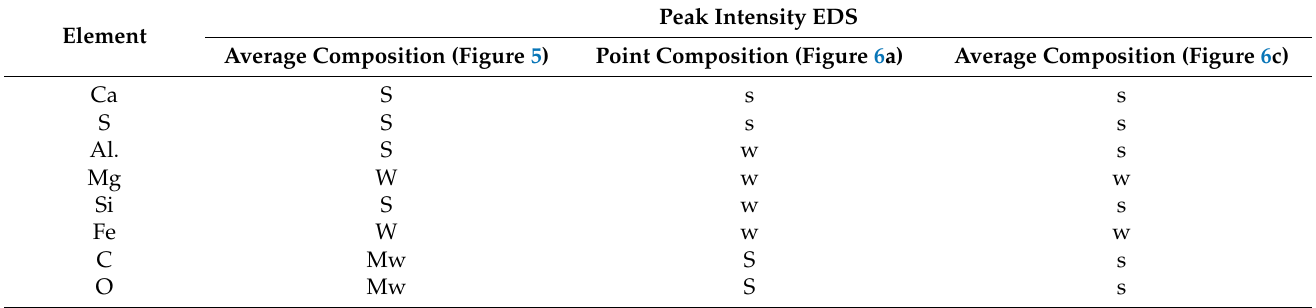
Table 4. Elementary composition (EDS).